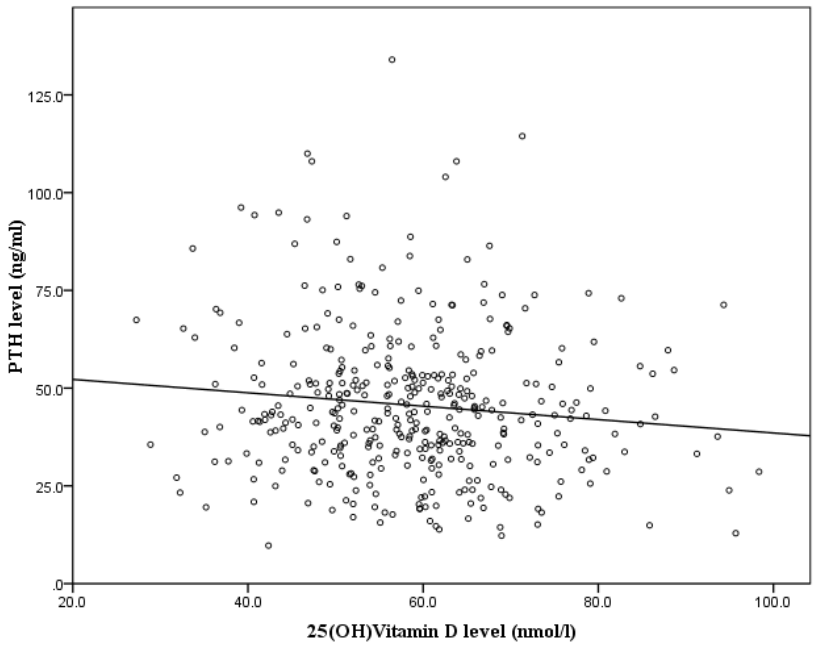
Figure 2. Scatter plot of the parathyroid (PTH) level versus the 25(OH)D level in the serum.